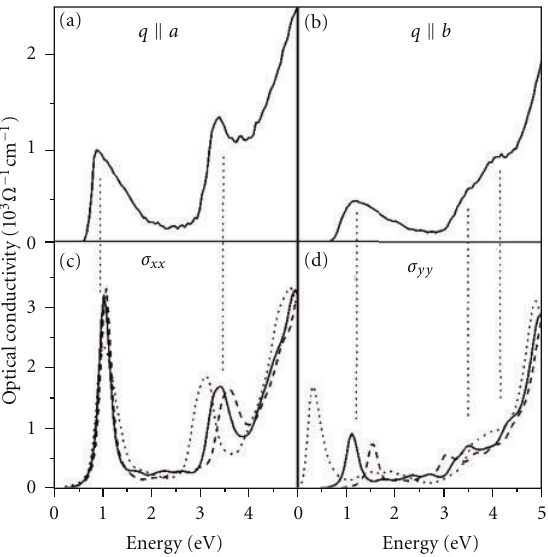
Figure 34: The optical conductivity σ xx (c) and σ yy (d) of α (cid:2) -NaV 2 O 5 determined by LDA and LDA+ U band structure calcu- lations with U e ff = 0 (dotted line), 2 (solid line), and 3eV (dashed line) compared with those derived from the experiment ((a) and (b)). The theoretical curves are broadened with a Lorentzian of 0.2eV width. The vertical dotted lines illustrate the correspondence of the peak